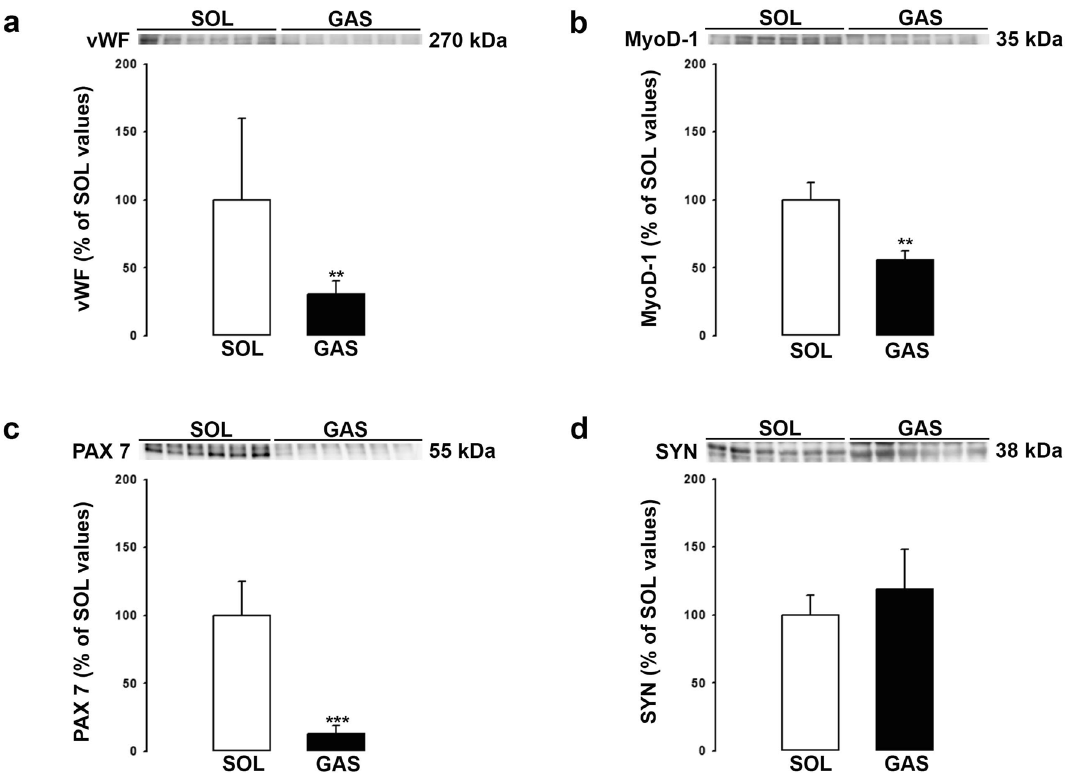
Figure 5. Cellular density of specific markers of endothelial (vWF), satellite (MyoD-1/PAX 7) cells and axonal processes of motor neurons (SYN). Expression of vWF (270 kDa, a ), MyoD-1 (35 kDa, b ), PAX 7 (55 kDa, c ) and SYN (38 kDa, d ) were determined in SOL and GAS muscles of control rats (n = 6 per group) by Western blotting method. Results are expressed as percentage of SOL muscle values (means ± SD). **p < 0.01, ***p < 0.001 versus SOL muscle. Representative immunoblots of each marker are shown above bar chart.